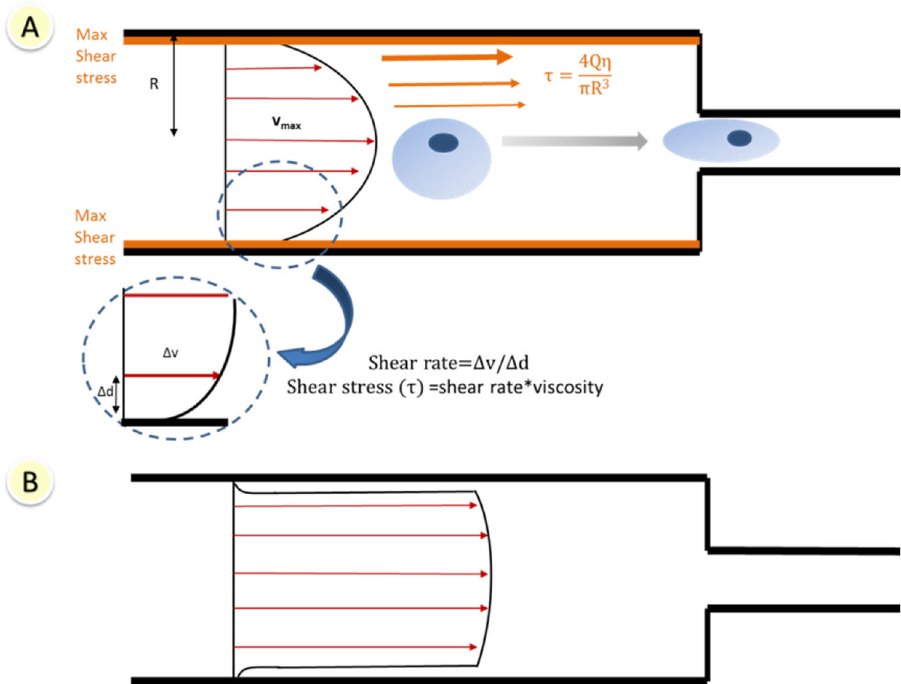
Fig. 2 Schematic of a section of a syringe/needle lumen of radius R . a Shear stress and velocity distribution in delivery device for Newtonian fl uid and laminar fl ow. The velocity pro fi le across the diameter is parabolic. Shear stress ( τ ) is zero at the centre and increases linearly to its maximum value at the wall. As a cell fl ows from the syringe to the needle, it will experience increasing velocities along its length, causing it to stretch. b Plug fl ow behaviour — fl ow velocities are almost equal across the whole diameter. Shear-thinning materials display this behaviour when their fl ow in a capillary reaches a steady